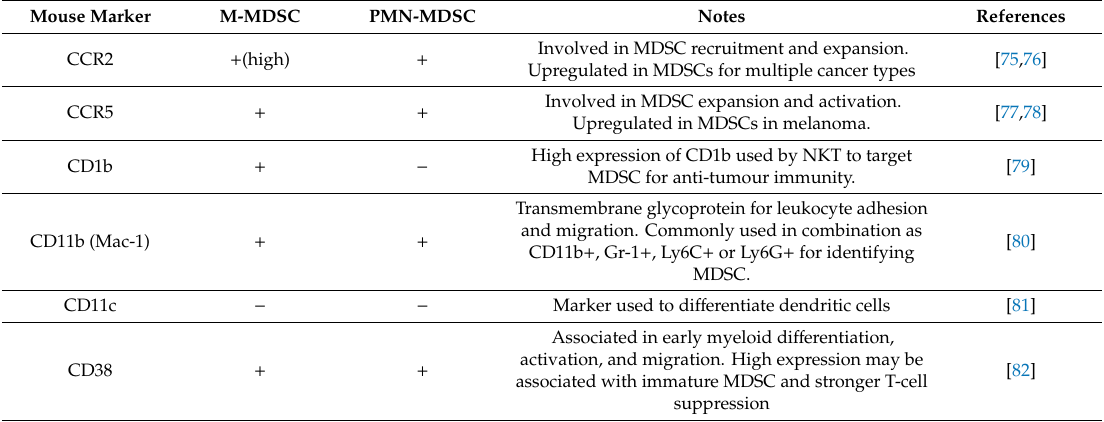
Table 1. Markers used to identify MDSC populations and functions in animal